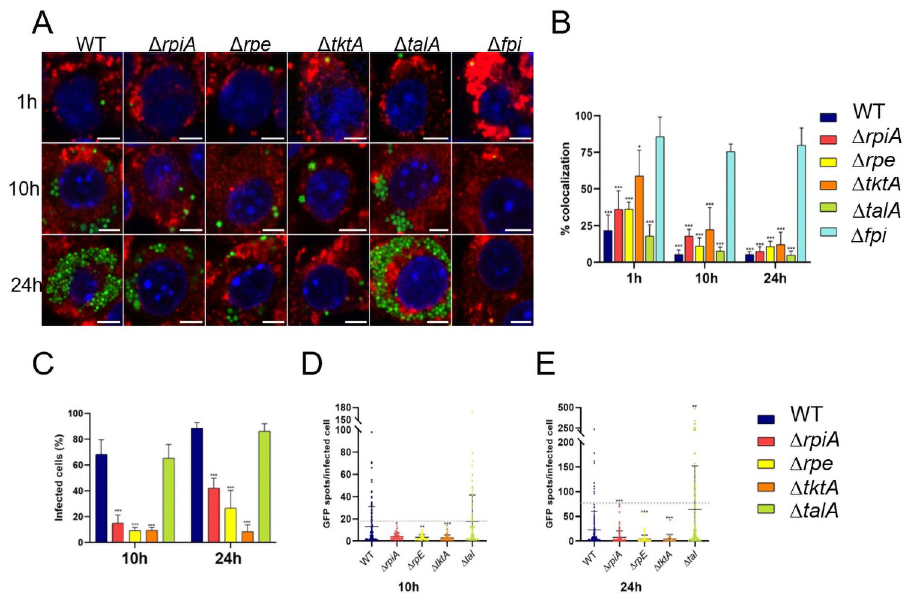
Fig 4. Subcellular localization of the PPP mutants. Glucose-grown J774.1 were infected for 1 h with wild-type F . novicida (WT), Δ rpiA , Δ rpe , Δ tktA , Δ talA , or Δ FPI strains and their co-localization with the phagosomal marker LAMP-1 was observed by confocal microscopy 1h, 10h and 24 h, after beginning of the experiment. ( A ) Scale bars at the bottom right of each panel correspond to 5 μ m. J774.1 were stained for F . tularensis ( green ), LAMP-1 ( red ), and host DNA ( blue , DAPI stained). ( B ) Quantification of bacteria/phagosome colocalization in glucose-grown J774.1 macrophages. Mean and SD of triplicate wells. ��� p < 0,0001 (compared to Δ FPI strain; as determined by ANOVA one- way test). ( C ) Percentage of infected cells at 10 and 24 h was quantified by using imageJ software. At least 1 000 cells per condition were counted. ��� p < 0,0001 (compared to WT strain; as determined by ANOVA one-way test). The number of GFP-positive spots per infected cell was quantified at 10h ( D ) and 24 h ( E ) by using the Icy Software. We analyzed at least 100 infected cells for each condition. ��� p < 0,0001 (compared to WT strain; as determined by ANOVA one-way test).